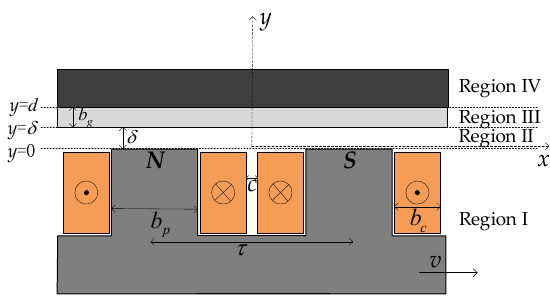
Figure 1. 2D simplified eddy current braking model.